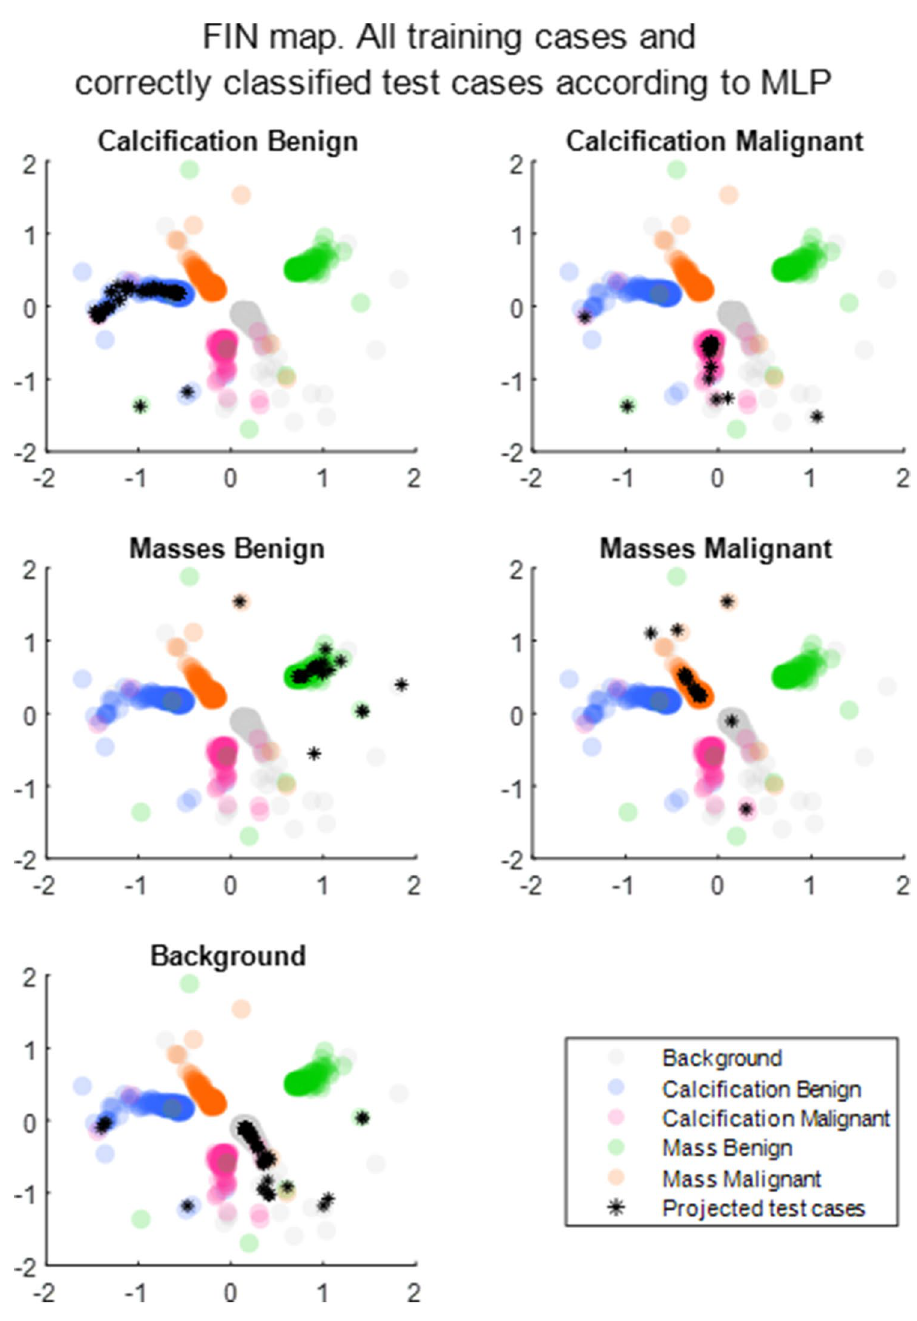
Figure 5. FIN map: all training cases and correctly classified test cases according to the MLP. Correctly classified test cases (black stars) projected into the trained FIN embedding, where every case is represented by a point—transparency was added mainly to allow for overlapping cases to be seen, and as a result, areas with the majority of cases in one class will display a more solid